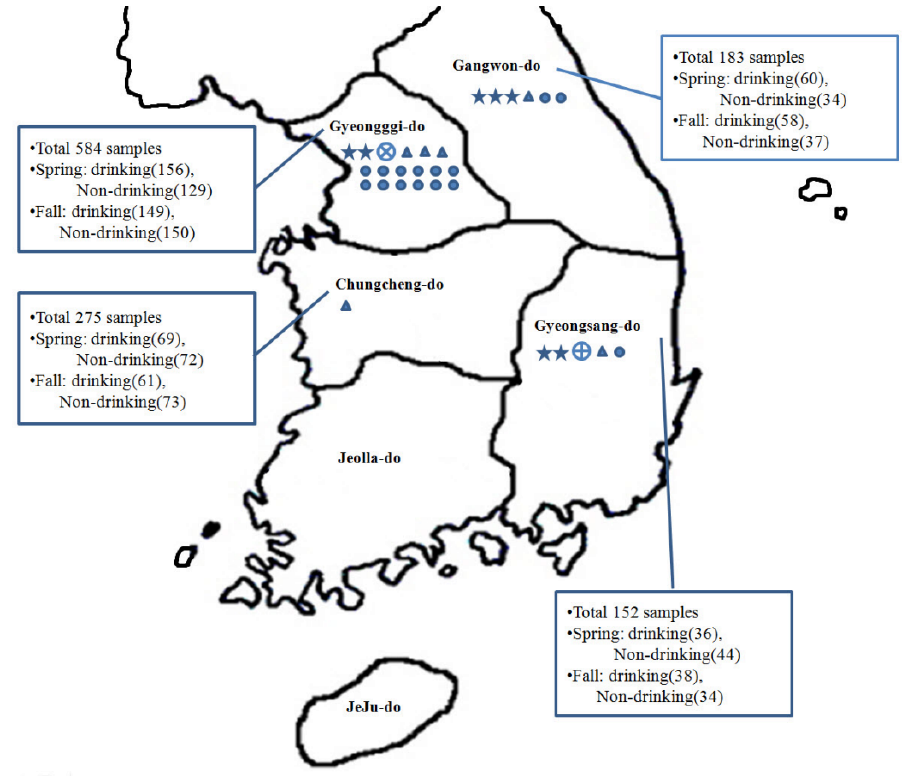
Figure 1. Map showing groundwater sampling locations and pathogen